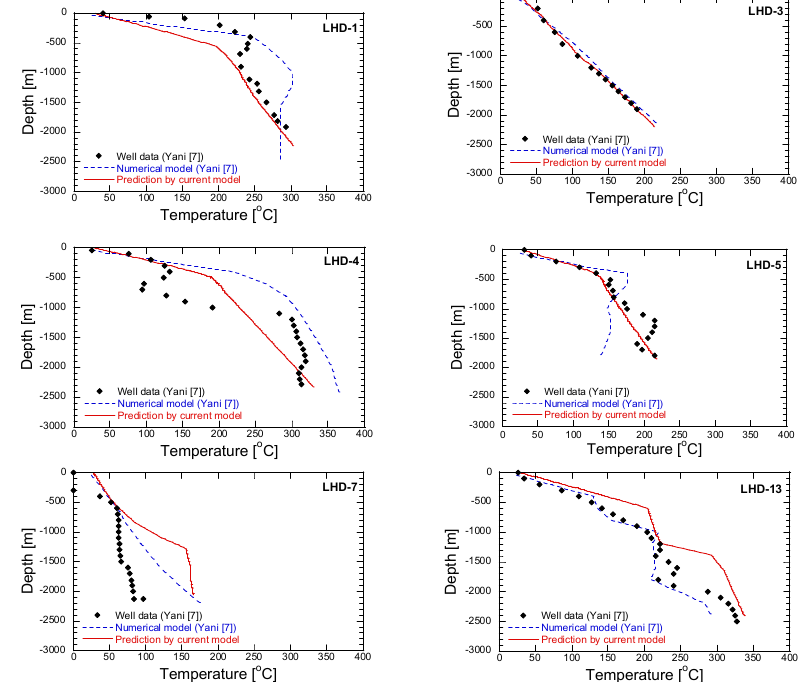
Figure 17. Comparison of measured and simulated temperature in natural state condition.